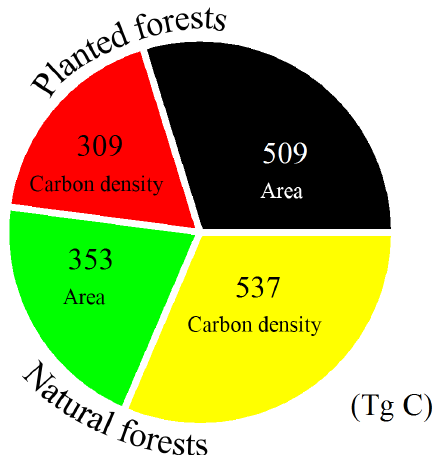
Figure 5. Summary of the forest biomass carbon sinks attributing to areal expansion and increase in carbon density for planted and natural forests of China in the period